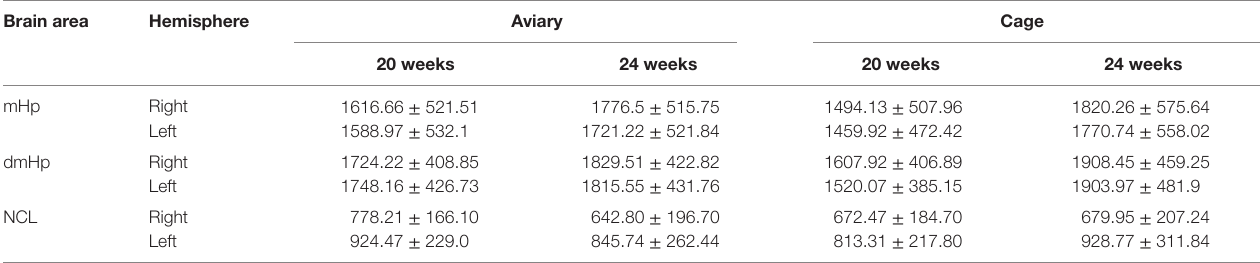
TaBle 1 | Mean and sD values for tyrosine hydroxylase staining intensity in the chicken mhp, dmhp, and ncl. Brain